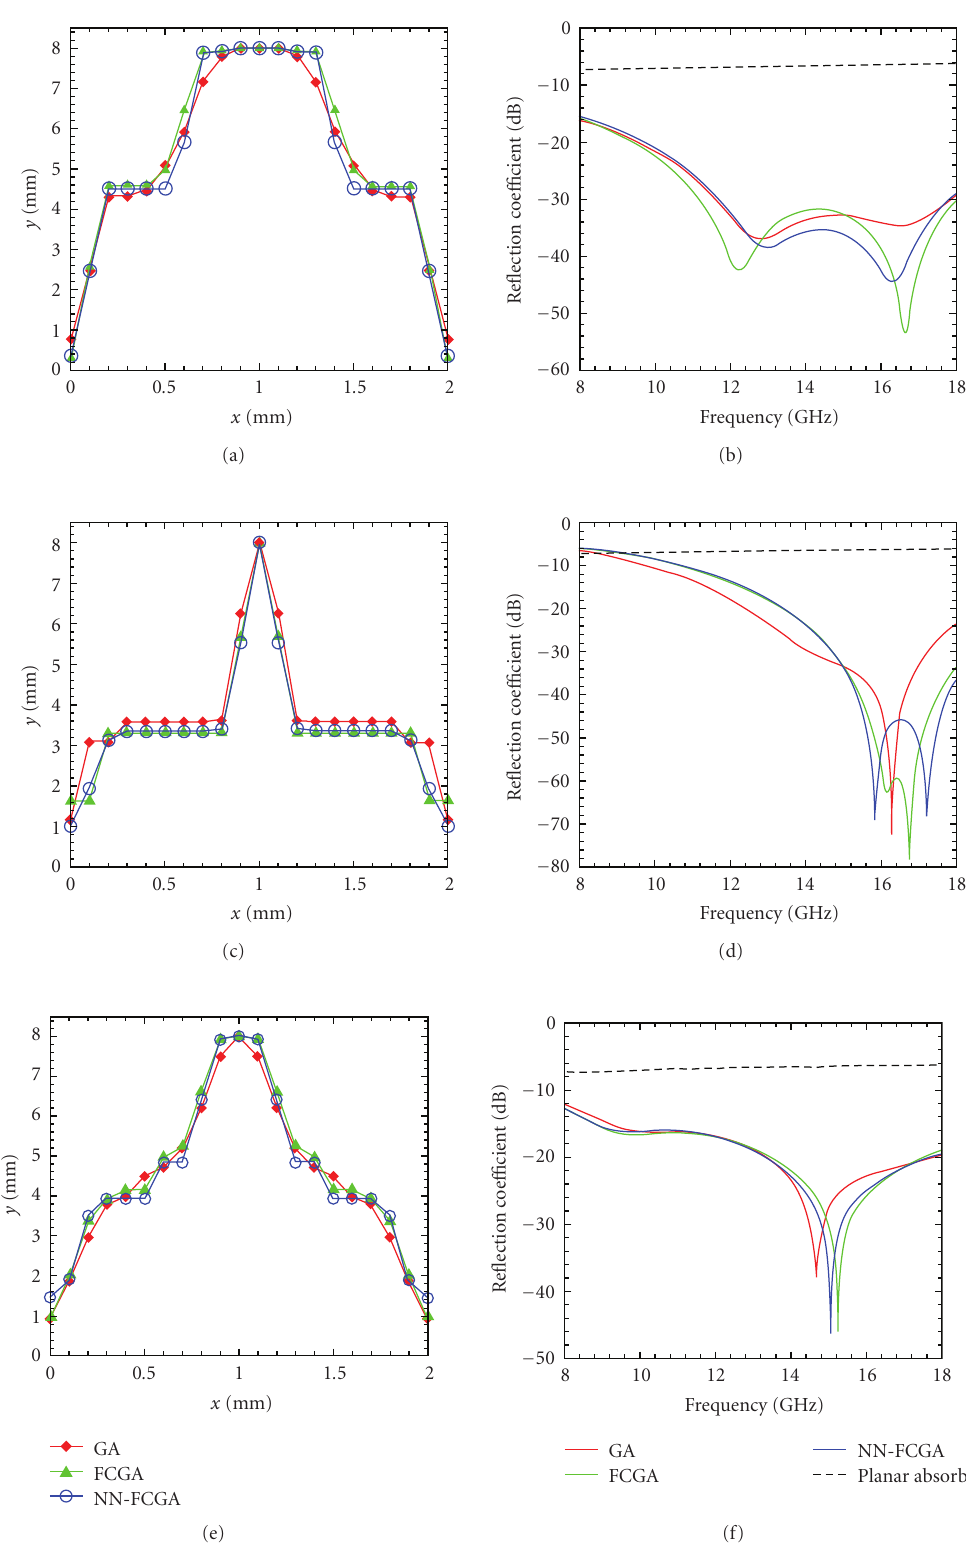
Figure 9: (a)–(c) Reflection coe ffi cient versus frequency for TM polarization, TE polarization, TM + TE polarization absorber designs, respectively. (d)–(f) Corresponding optimized shapes for TM polarization, TE polarization, TM + TE polarization absorber designs, respectively. In these cases, the GA (red line), FCGA (green line), and NN-FCGA (blue line) are performed for